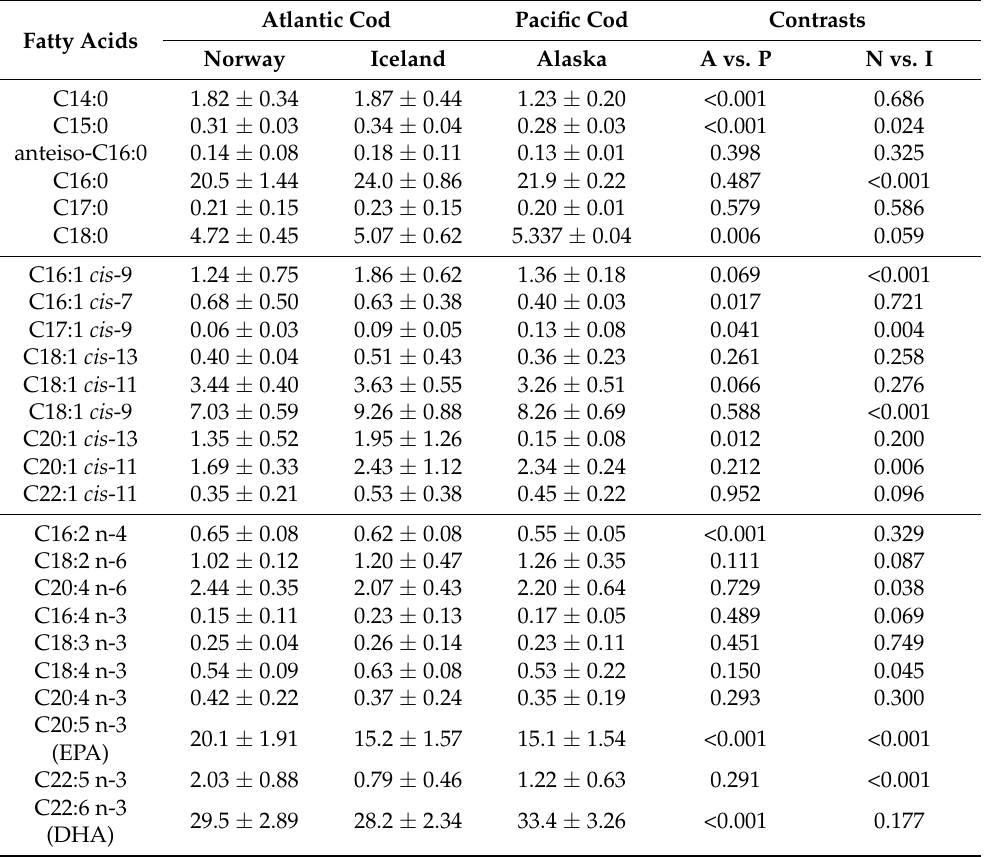
Table 2. Fatty acid profiles of dried salted cod edible portion obtained from the Atlantic and Pacific cod species and from different harvesting locations within the Atlantic cod (expressed as g/100 g of total fatty acids; mean ± standard deviation). Atlantic Cod Pacific Cod Contrasts Fatty Acids Norway Iceland Alaska A vs. P N vs.